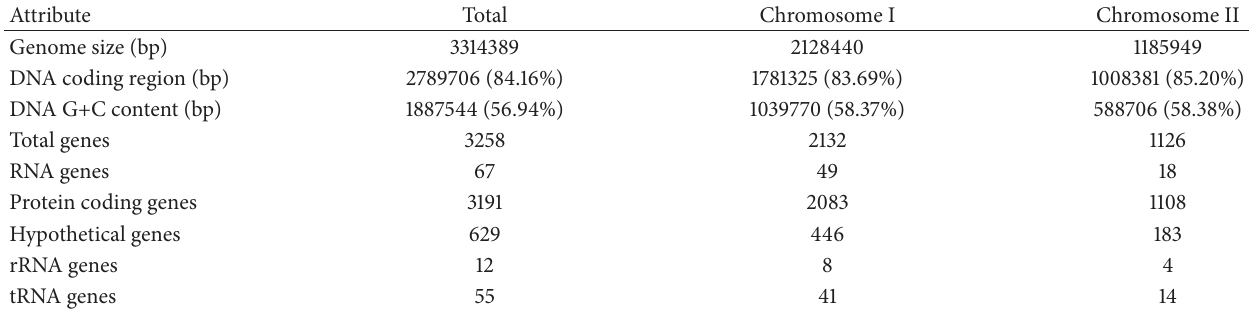
Table 2: Structural annotations of Bm IND1